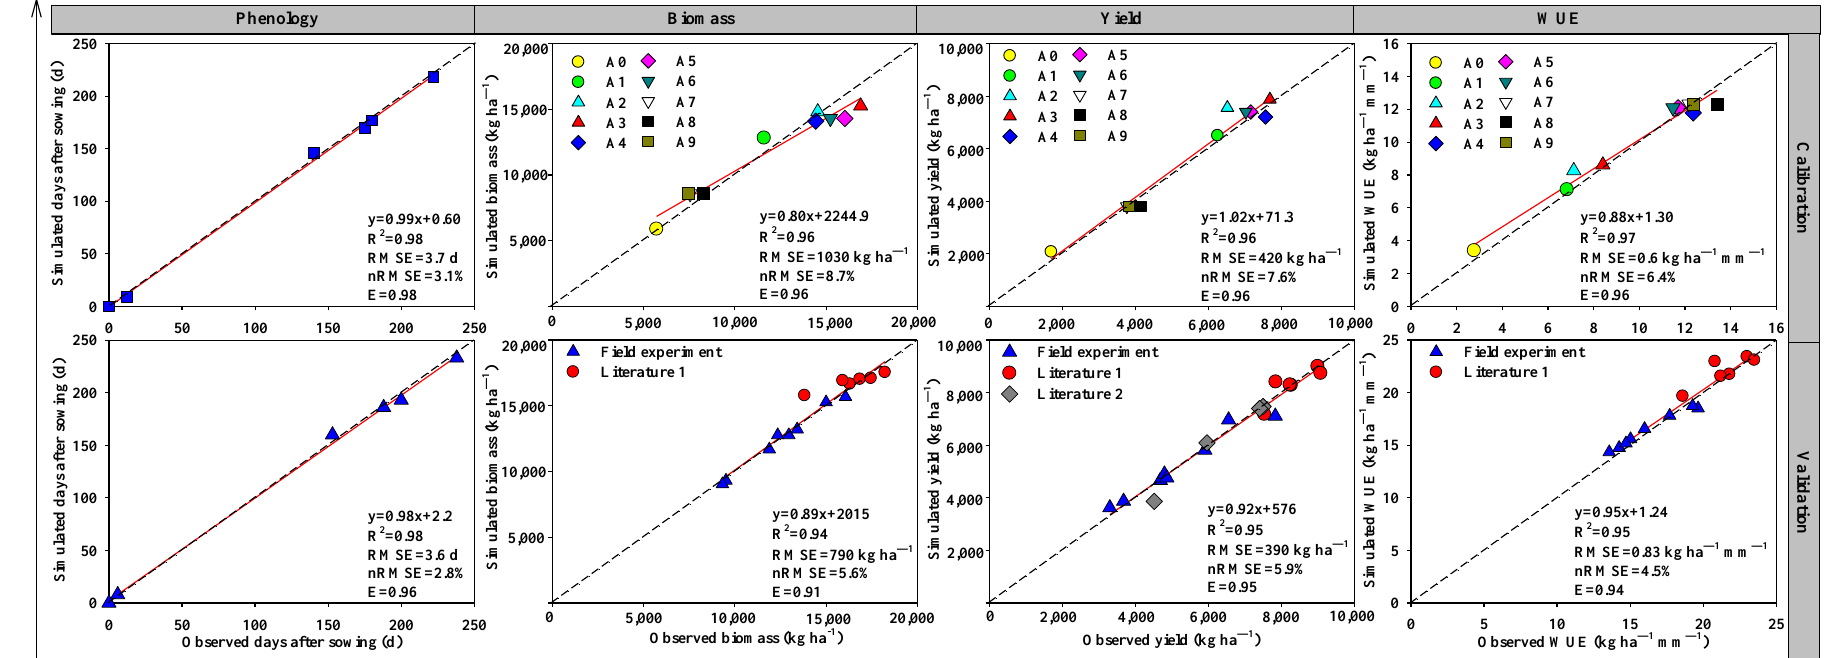
Figure 1. Comparison of simulated and observed values of phenology, biomass, yield, and WUE for model calibration and validation.